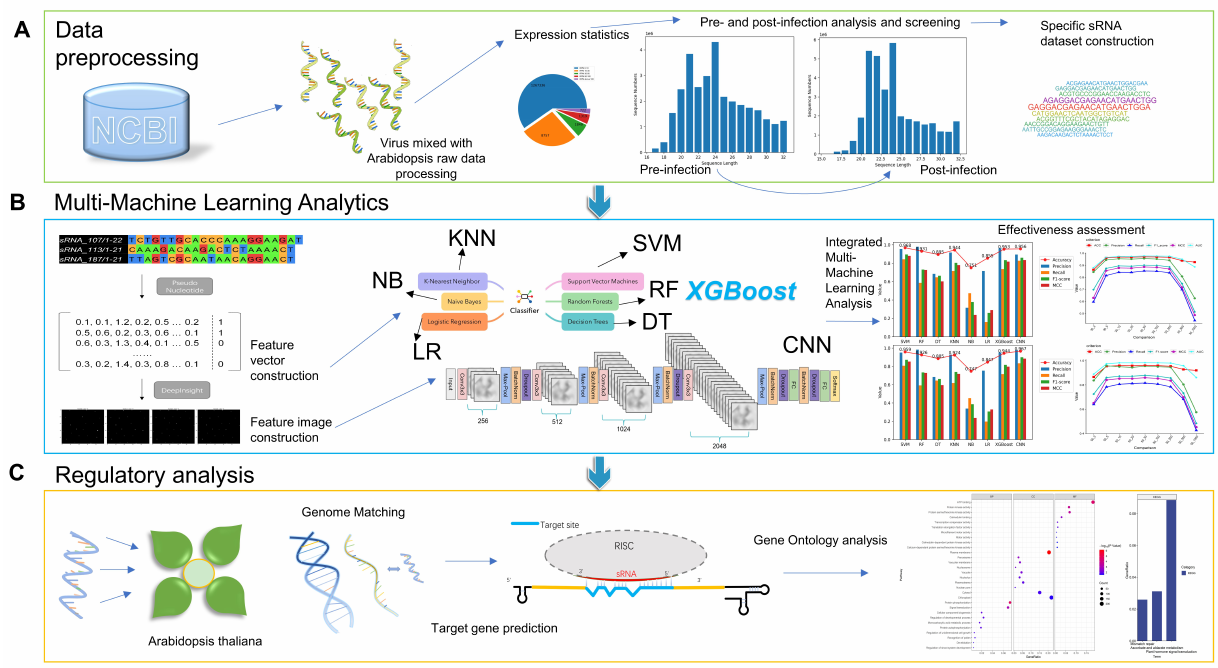
Figure 3. Entire experimental design scheme: ( A ) Data pre-processing stage: Process high-throughput data to count sRNA expression, obtain sRNAs with significant expression changes before and after infection, and divide multiple ranges to construct specific sRNA datasets. ( B ) Multi-machine learning analysis phase: constructing sequence features of the obtained positive and negative samples and analyzing different ranges using multiple models. ( C ) Regulatory analysis stage: We conducted genomic matching of the analyzed sRNAs to obtain possible sources and then started target gene prediction and performed functional enrichment analysis to obtain gene function regulation results in